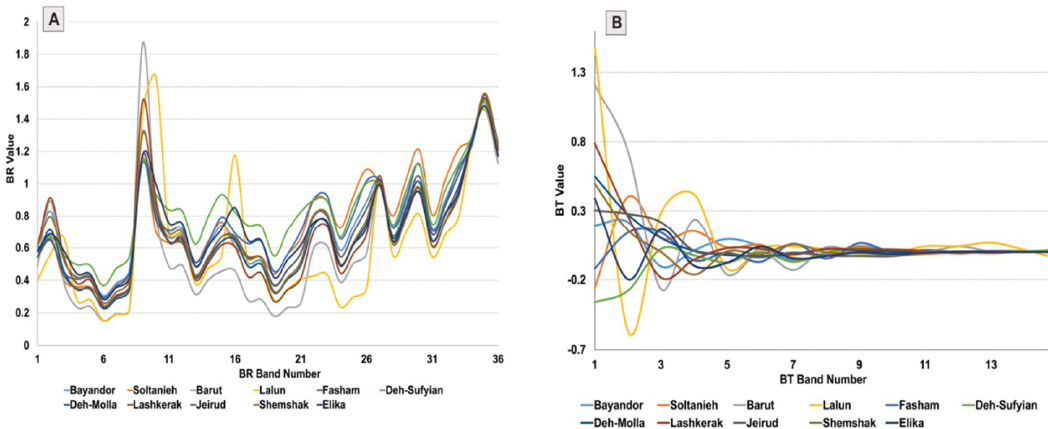
Figure 7. ( A ) Spectral signatures of the sedimentary formations in the study area extracted form band ratios (BR) matrix; ( B ) spectral signatures of the sedimentary formations after applying BRMT.